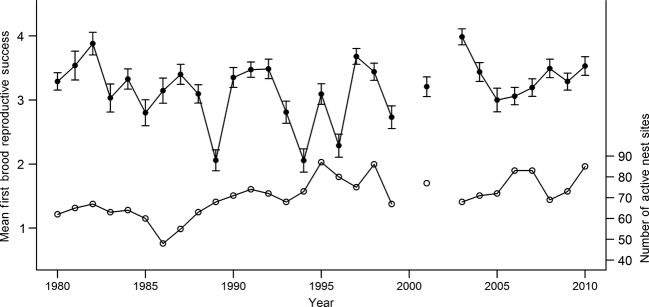
Predicted mean first brood reproductive success (RSFL left axis, filled circles) ±1 SE of European starlings on Fair Isle. The number of active nest sites on the island is also shown (right axis, open circles) in each year (excluding 2000 and 2002).